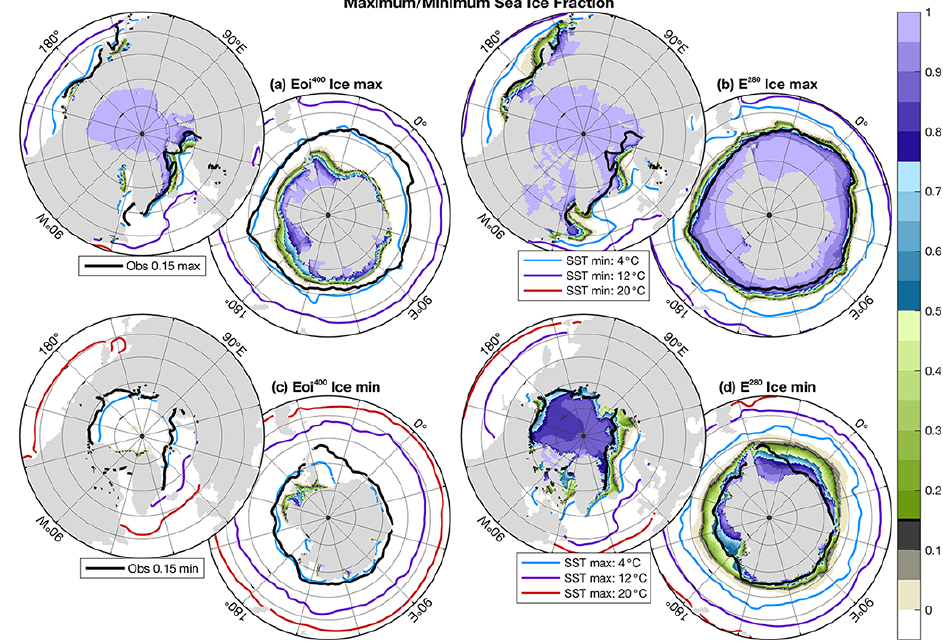
Figure 6. (a) Eoi 400 mean maximum monthly sea ice fraction over northern and southern polar regions. Coloured contours show coldest- month mean SST, and the black contour indicates the late 21st century observed September (NH) or March (SH) sea ice edge at an 0.15 fraction (indicated on the colour bar; Fetterer et al., 2017). Panel (b) is the same as (a) but for the E 280 case using the same contour intervals and sea ice edge data. Panels (c, d) are similar to (a, b) but show the monthly sea ice minimum, warmest-month mean SST and late 21st century observed March (NH) or September (SH) sea ice